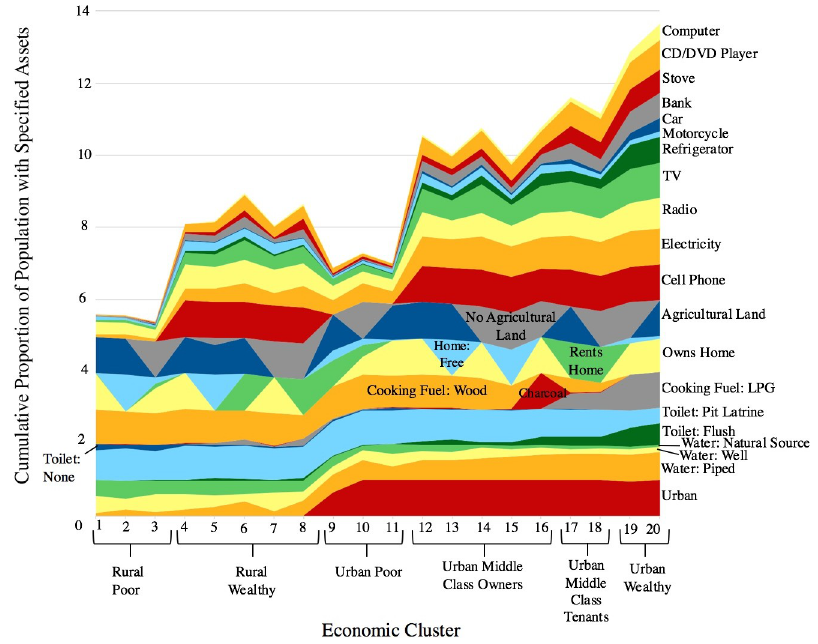
Fig 2. Distribution of various DHS Wealth Index assets among twenty Cameroonian EconomicClusters.